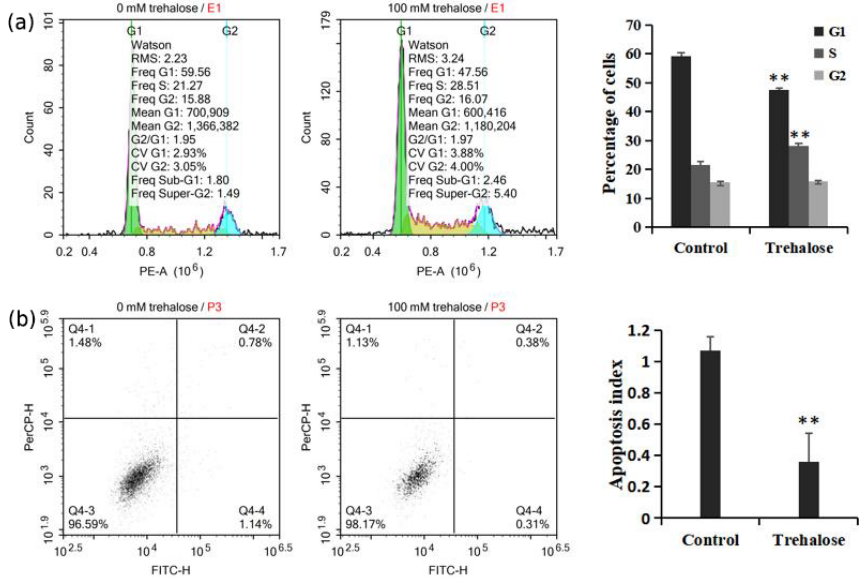
Figure 4. Effect of trehalose on cell cycle distribution and apoptosis of sheep EECs. The EECs were treated with trehalose (0 or 100mM) for 24h. (a) The cell cycle distribution in trehalose-free culture and 100mM trehalose culture. (b) Apoptosis rate of cells cultured without trehalose and with 100mM trehalose. * P < 0 . 05 and ** P < 0 . 01 vs. the trehalose-free group.